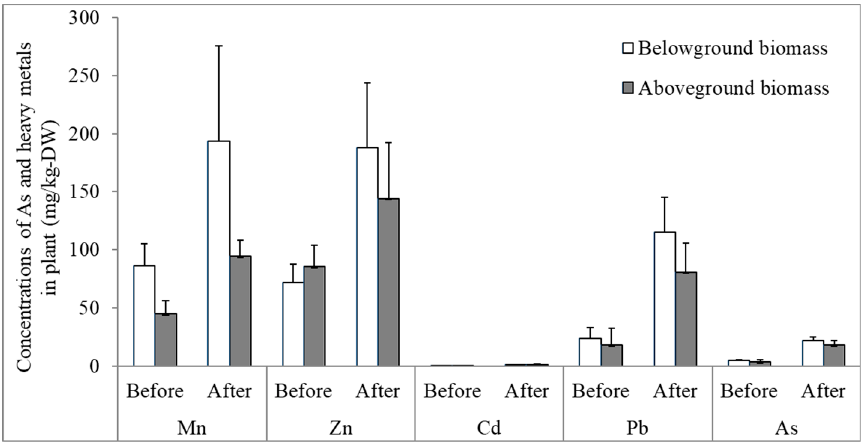
Figure 4 . Accumulation of As and heavy metals in Phragmites australis (mg/kg ‐ DW) after 4 months. Figure 4. Accumulation of As and heavy metals in Phragmites australis (mg / kg-DW) after 4